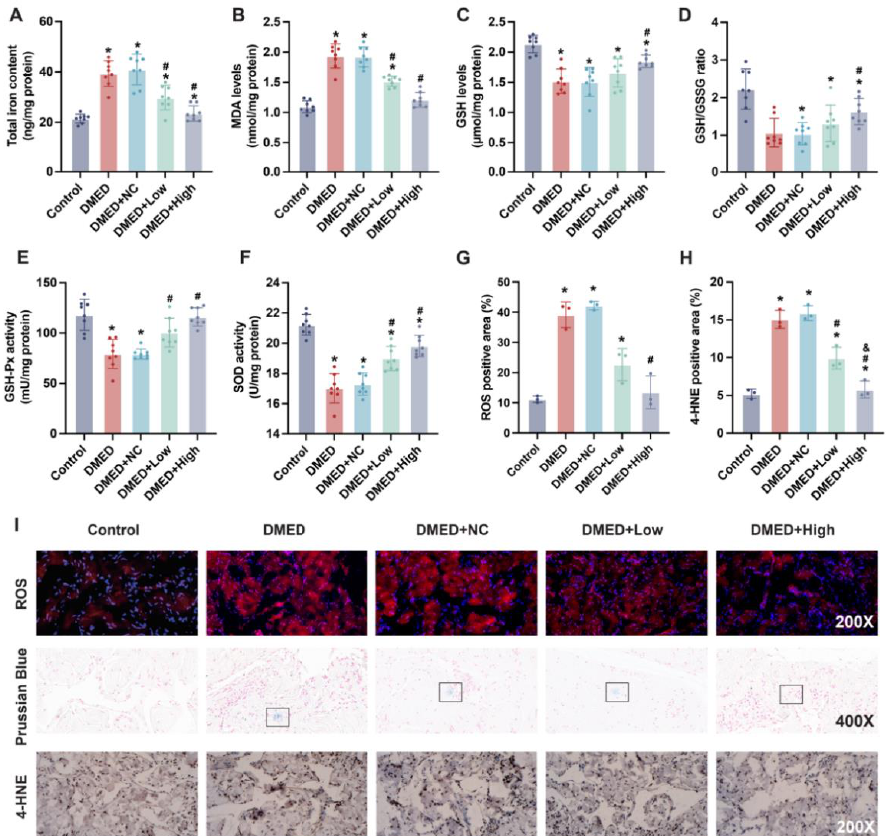
Figure 3. Effect of GPX4-LV injection on iron overload and oxidative stress in DMED rats. ( A ) Total iron content, ( B ) MDA levels, ( C ) GSH levels, ( D ) GSH/GSSG ratio, ( E ) GSH-Px activity, and ( F ) SOD activity in all five groups. Semi-quantification ( G , H ) and representative results ( I ) of ROS (200×), Prussian Blue (400×) and 4-HNE (200×) staining. * p < 0.05 compared with the control group. # p < 0.05 compared with the DMED group. & p < 0.05 compared with the DMED + low group.